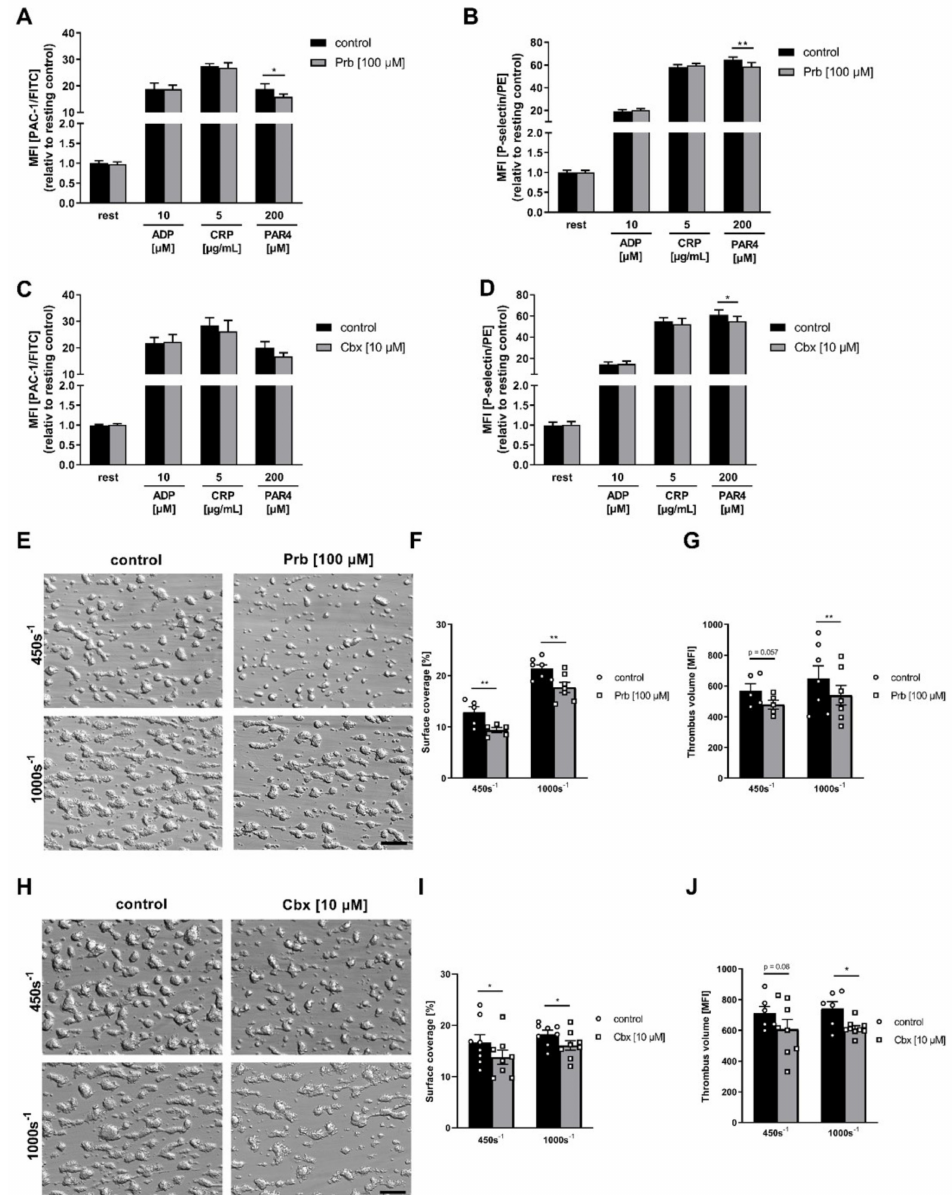
Figure 6. Pharmacological inhibition of PANX1 leads to reduced degranulation and thrombus formation under flow conditions: ( A – D ) Human platelets were washed, pre-incubated with indicated PANX1 inhibitors and activated with standard agonists. ( A , C ) Integrin α IIb β 3 activation (PAC1-FITC) and ( B , D ) P-selectin exposure were determined by flow cytometry with or without pretreatment using ( A , B ) Prb ( n = 7–11) and ( C , D ) Cbx ( n = 6). ( E – J ) Human whole blood was perfused over a collagen (200 µ g/mL) coated matrix with or without pretreatment using ( E – G ) Prb ( n = 5–7) and ( H – J ) Cbx ( n = 7–9). ( E , H ) Representative images of thrombus formation ex vivo using whole blood pretreated with Prb or Cbx and perfused over a collagen-coated matrix at a shear rate of either 450s − 1 and 1000s − 1 , respectively. Scale bars represent 100 µ M. ( F , I ) Analysis of surface coverage (%) and ( G , J ) thrombus formation (MFI). Statistical analyses were performed using a two-way ANOVA followed by a Sidak’s multiple comparisons post-hoc test. Bar graphs indicate mean values ± SEM, * p < 0.05 and ** p < 0.01. Rest = resting, ADP = adenosine diphosphate, CRP = collagen-related peptide, PAR4 peptide = protease-activated receptor 4 peptide, Prb = probenecid, Cbx = carbenoxolone, MFI = mean fluorescence